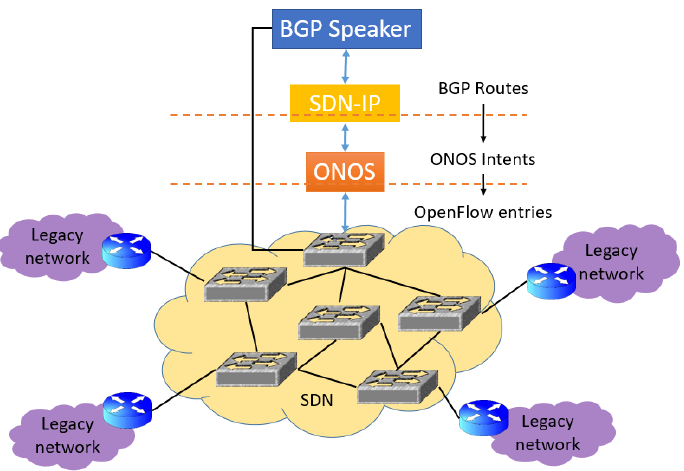
Figure 1. Use case network of SDN integration with legacy networks .